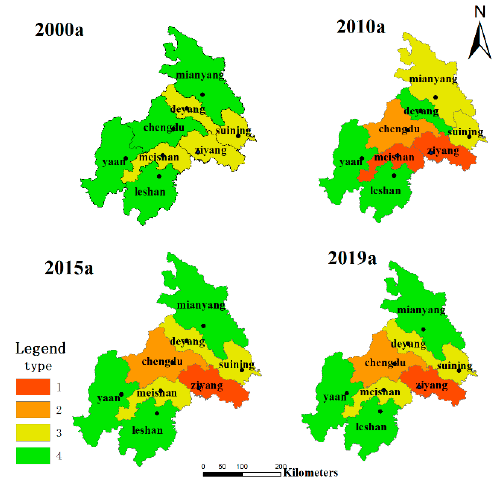
Figure 7. Spatial and temporal distribution of ecological sustainability in 8 cities.